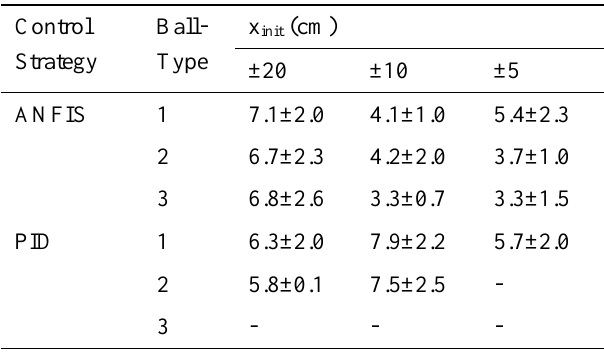
Comparison of settling time